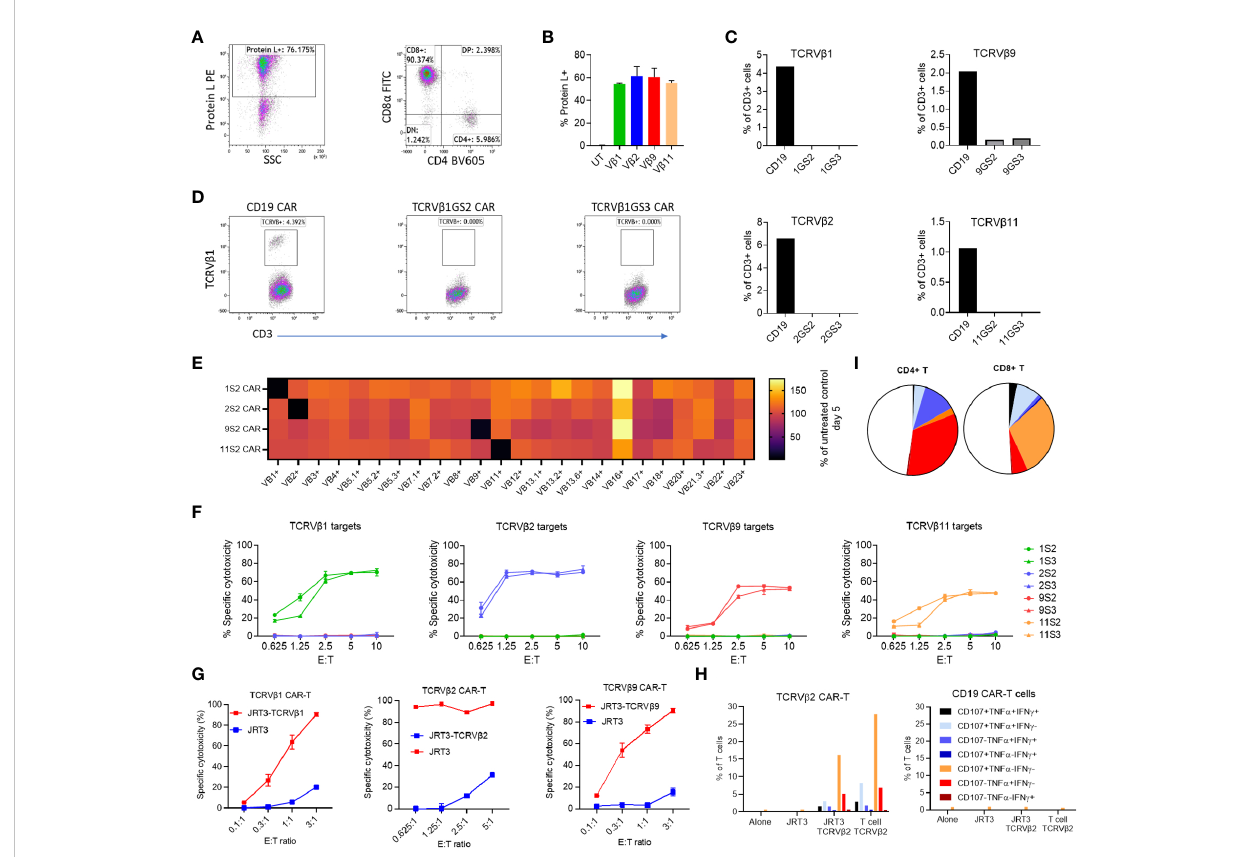
FIGURE 1 Ef fi cacy and lack of signi fi cant off-target killing of primary T cells by V b -speci fi c CAR-T cells. PBMC were transduced with anti-V b 1, -2, -9, -11 or -CD19 CAR constructs. After three days the transduction ef fi ciency was evaluated by protein L staining and the frequency of CD3+ T cells expressing each targeted V b subunit was quanti fi ed by fl ow cytometry. (A) Representative dot plots of CAR expression and phenotype of transduced cells. (B) Frequency of CAR-expressing cells in each culture. (C) Frequency of T cells expressing TCRV b 1, -2, -9 or -11 in transduced T cells.